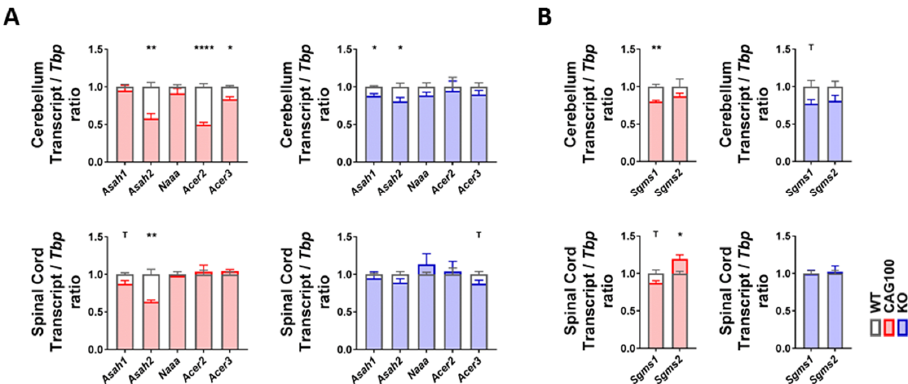
Figure 5. Transcript levels of the enzymes utilizing ceramide were studied in the cerebellum and spinal cord of Atxn2 -CAG100-KIN and Atxn2 -KO mice. ( A ) Expression levels of ceramidase isoforms involved in ceramide breakdown into sphingosine/sphinganine. ( B ) Expression levels of sphingomyelin synthase isoforms catalyzing the synthesis of sphingomyelin species utilizing ceramide. Student’s t -test was used with Welch’s correction; T p < 0.1, * p < 0.05, ** p < 0.01, *** p < 0.001, **** p < 0.0001.